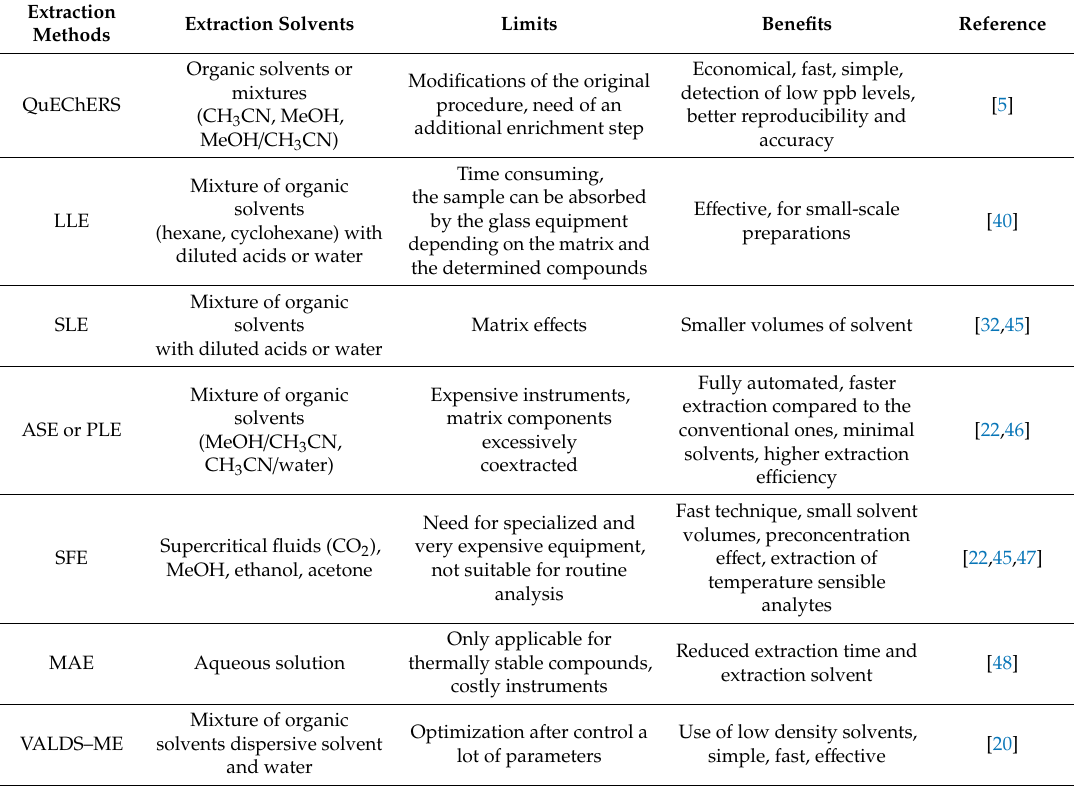
Table 1. Extraction methods and solvents of